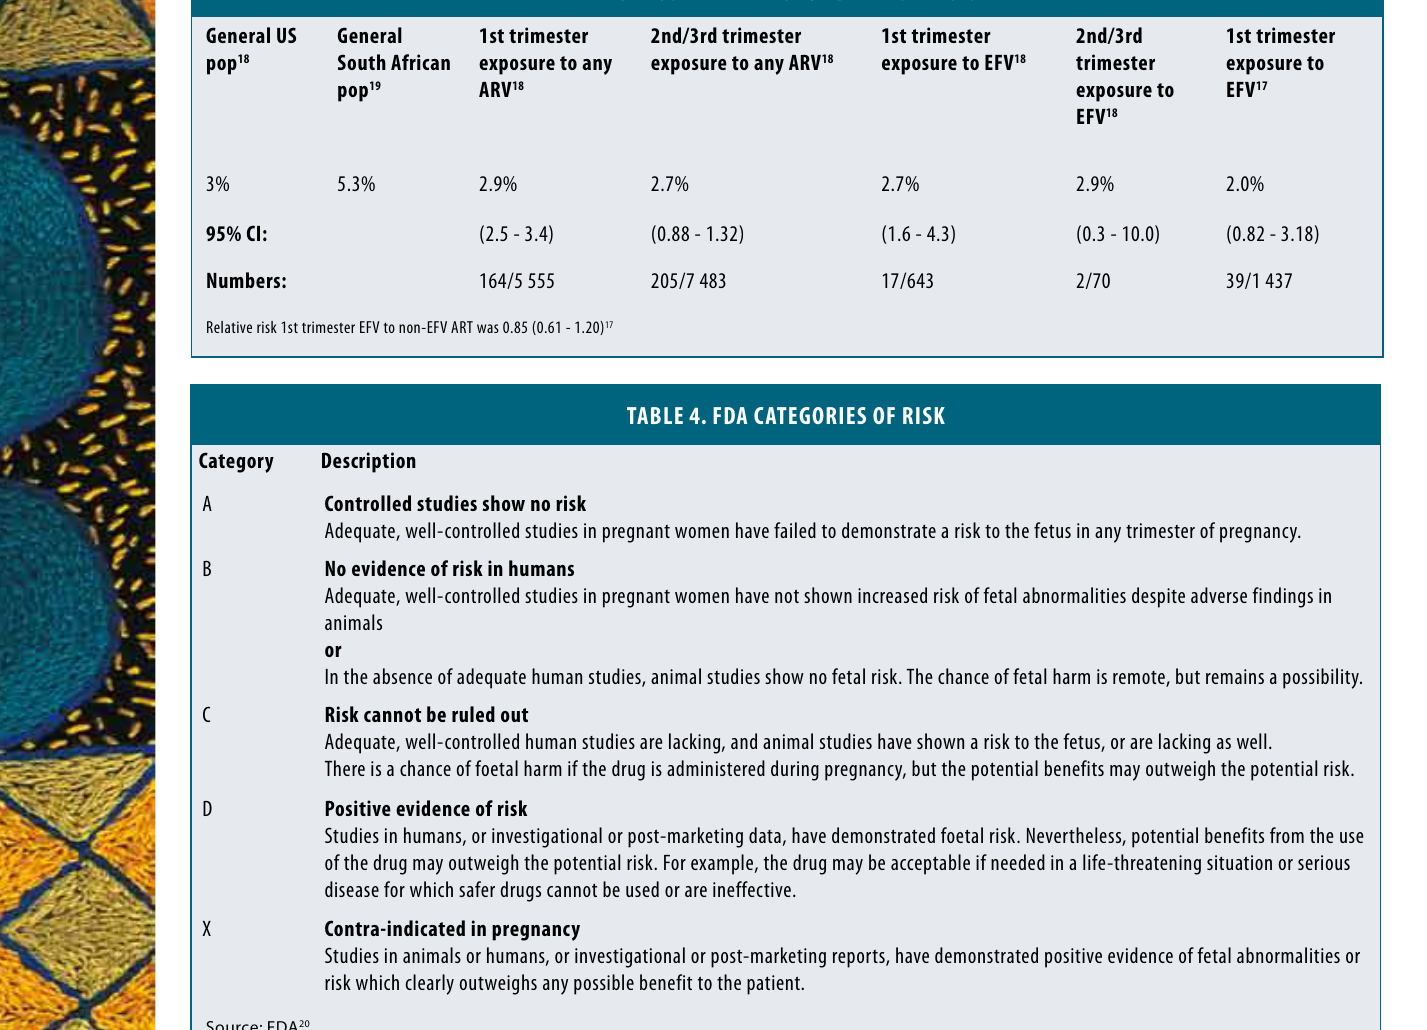
taBle 3. prevalence of BIrth